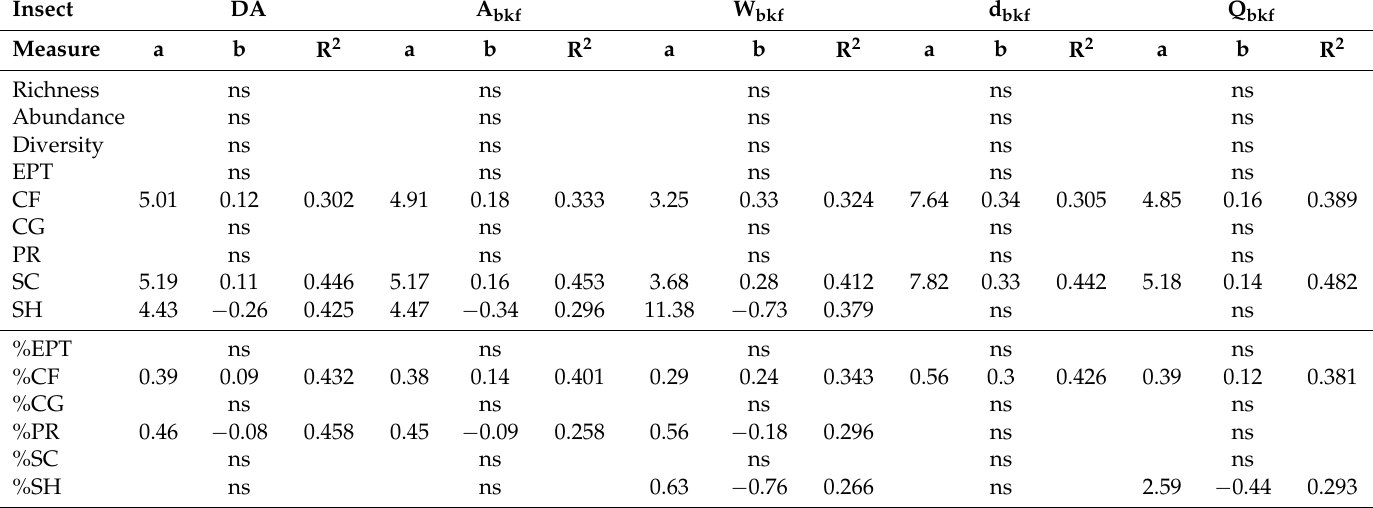
Table 10. Significant ( p < 0.05 ) relationships between measures of macroinvertebrate assemblages and bankfull dimensions for Alabama Piedmont reference streams. Values are the parameters (a and b) and coefficient of determination (R 2 ) for the power model y = ax b , where y is the macroinvertebrate measure and x is the bankfull dimension measure. EPT, CF, CG, PR, SC, and SH refer to taxa richness of those respective functional feeding groups, whereas measures preceded by a “%” refer to percent of total insect assemblage comprising that functional feeding group. See text for definitions of insect and geomorphic